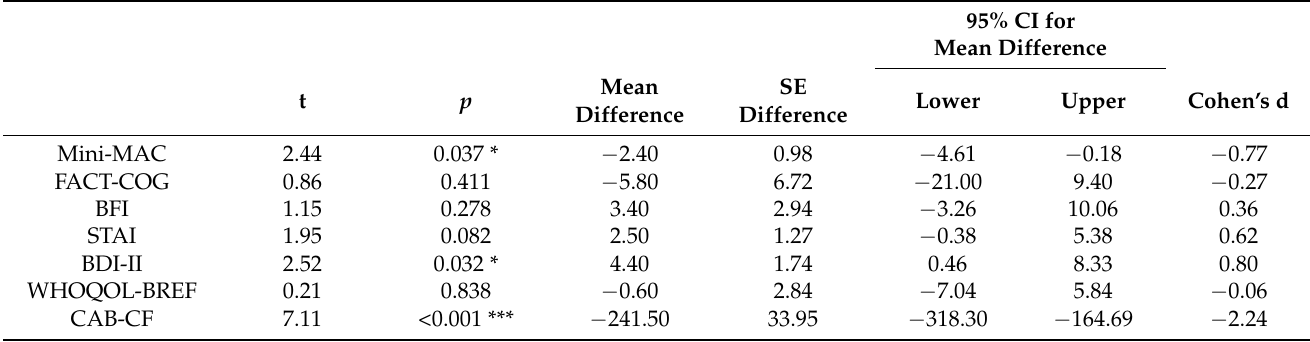
Table 4. Paired samples t -test for assessment measures pre- and post- cognitive stimulation intervention.